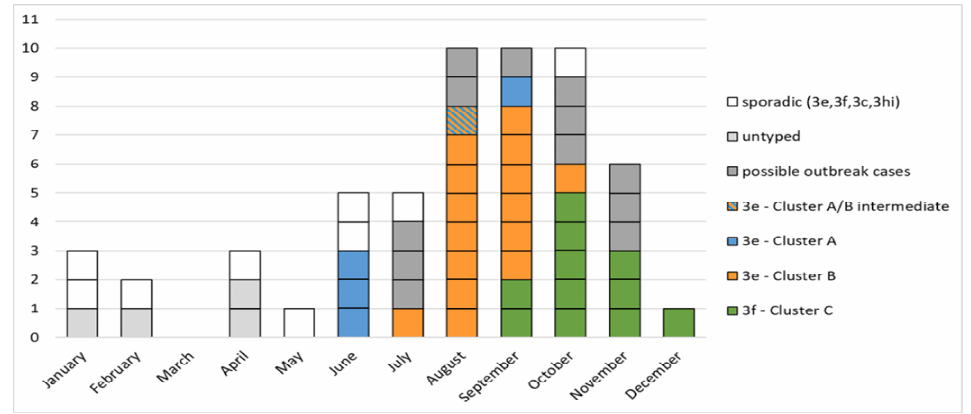
Figure 2. Outbreak curve by onset date. The grey boxes represent cases with no sequence available. The three molecular clusters (Cluster A, B, and C) partially showed overlapped temporal distribution: three Cluster A cases occurred in June and a fourth case in Sep-